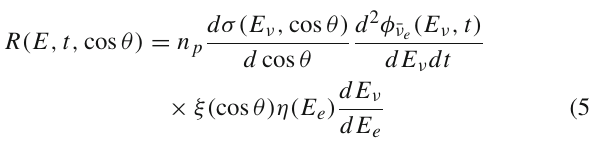
4 Modelling SN1987A event-by-event likelihood Frequently the likelihood treatment in particle